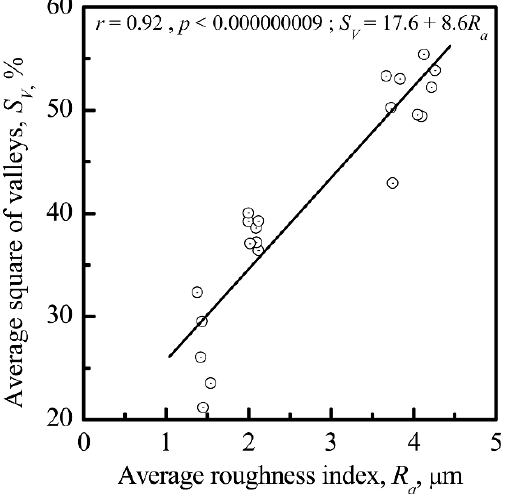
Figure 11. Correlation between the average area of valleys ( S V ) and the average roughness index ( R a ) of the CP surface.